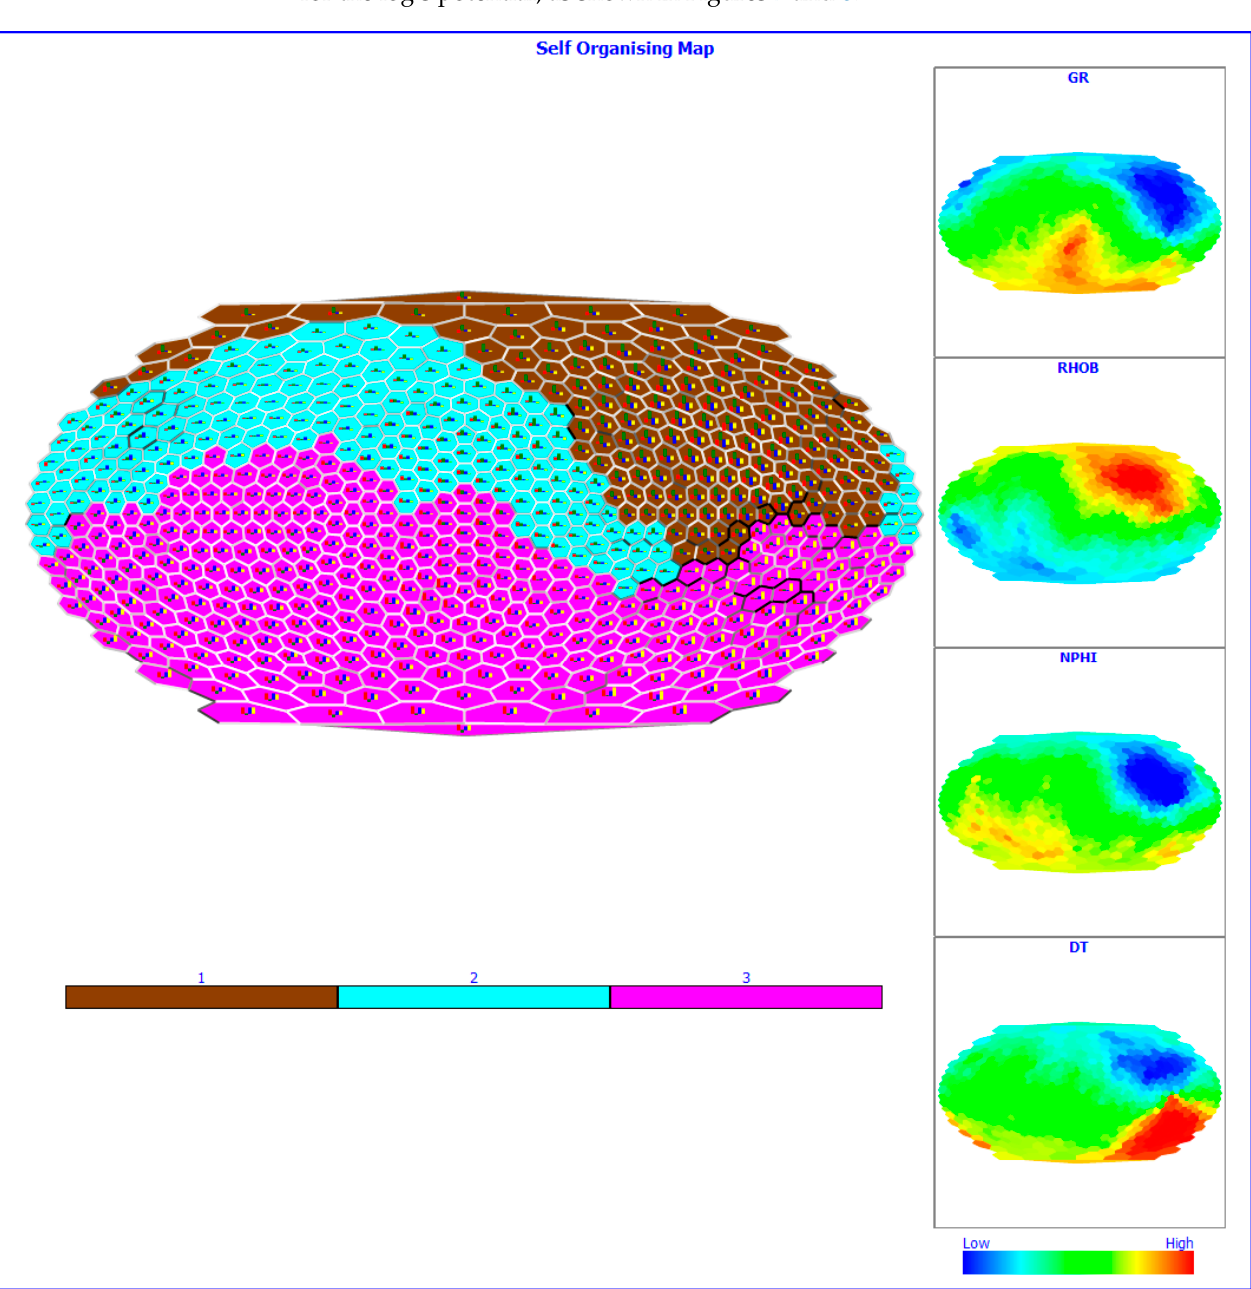
Figure 7. Calibrated SOM QGF well 03 outputs with corresponding color indices highlighting individual log impacts.